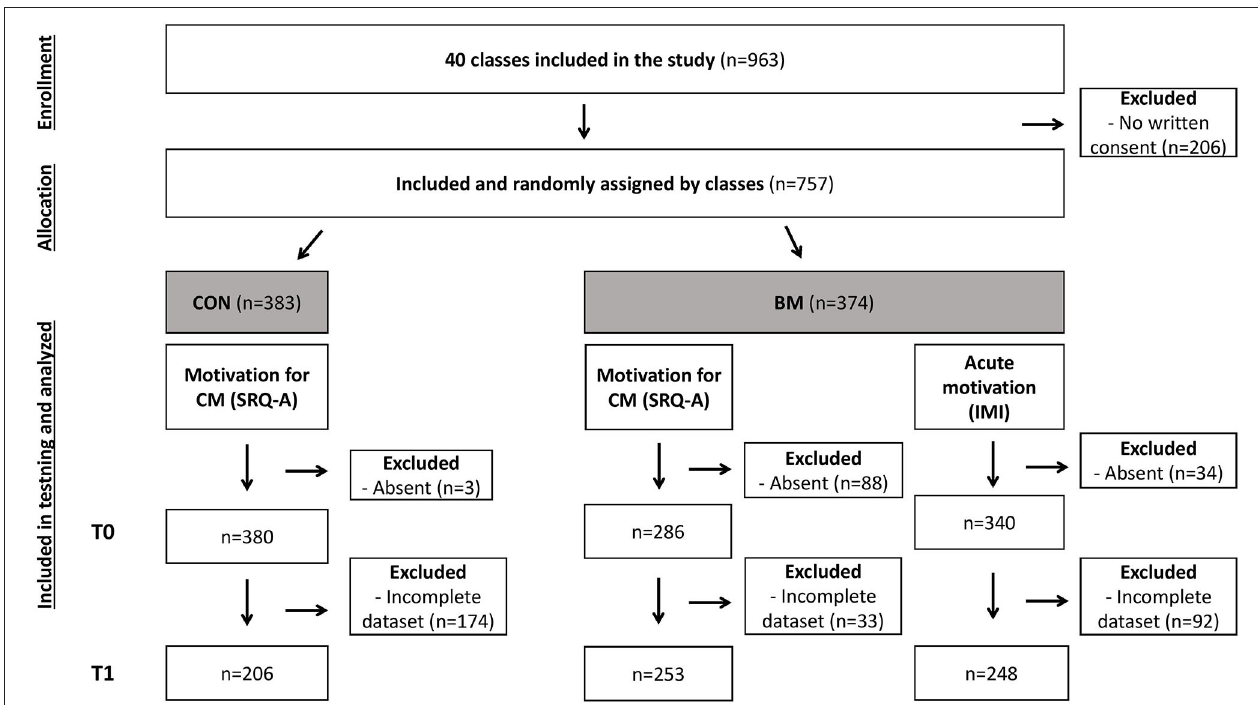
FIGURE 1 | Flow diagram. Flow diagram of the study. Seven hundred fifty-seven children were randomly assigned to either basketball sessions without mathematics (CON) or basketball sessions combined with mathematics (BM). The children performed a questionnaire (SRQ-A) about their motivation for classroom-based mathematics (CM) before (T0) and after an intervention period of 6 weeks (T1). BM also performed a motivation questionnaire (IMI) acutely after a basketball session combined with mathematics and immediately after a session of classroom-based mathematics. Only complete cases were analyzed.